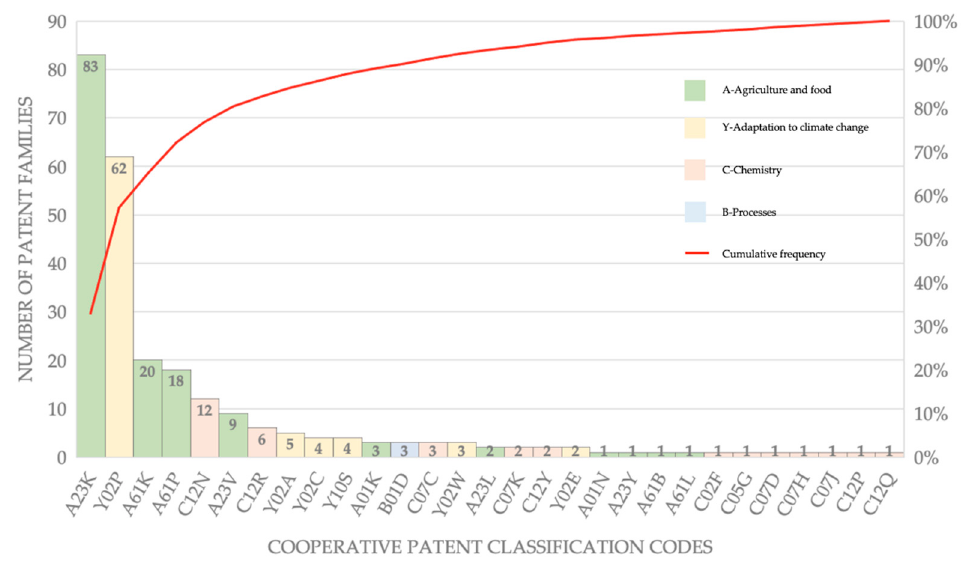
Figure 4. Patent families by CPC codes and relative weight in the portfolio.